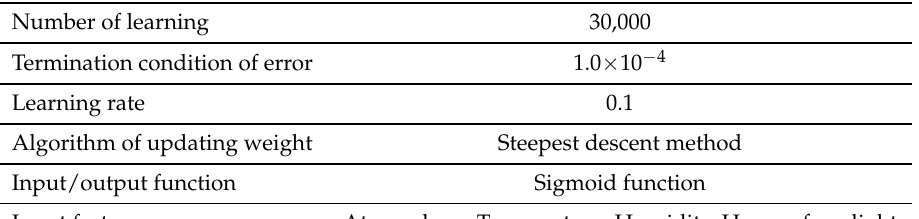
Table 3. Parameter entered into neural network toolbox in MATLAB R (cid:13) .